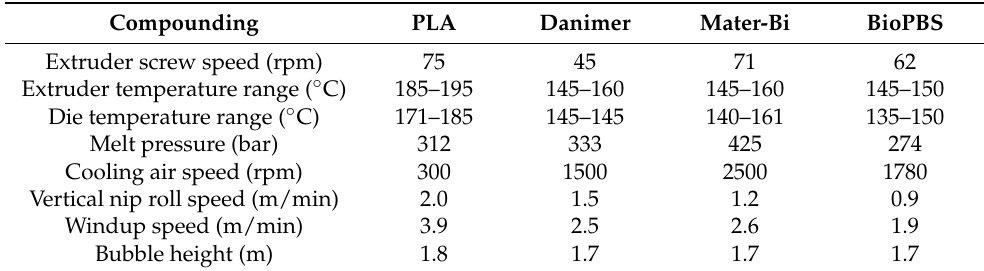
Table 15. 1st film generation optimal blowing